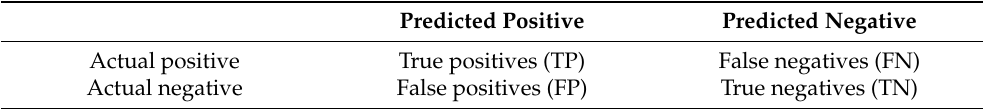
Table 1. Binary classification confusion matrix.